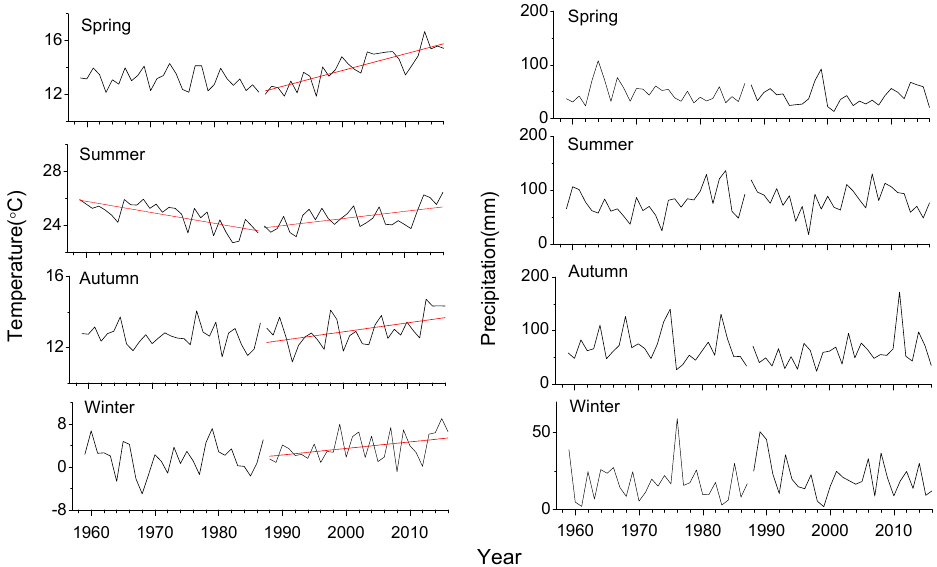
Figure 2. Trends in the seasonal temperature and precipitation values from 1960 to 2015 in Meixian. Lines indicate significant trends for two 28-year long sub-periods (1960–1987 and 1988–2015).